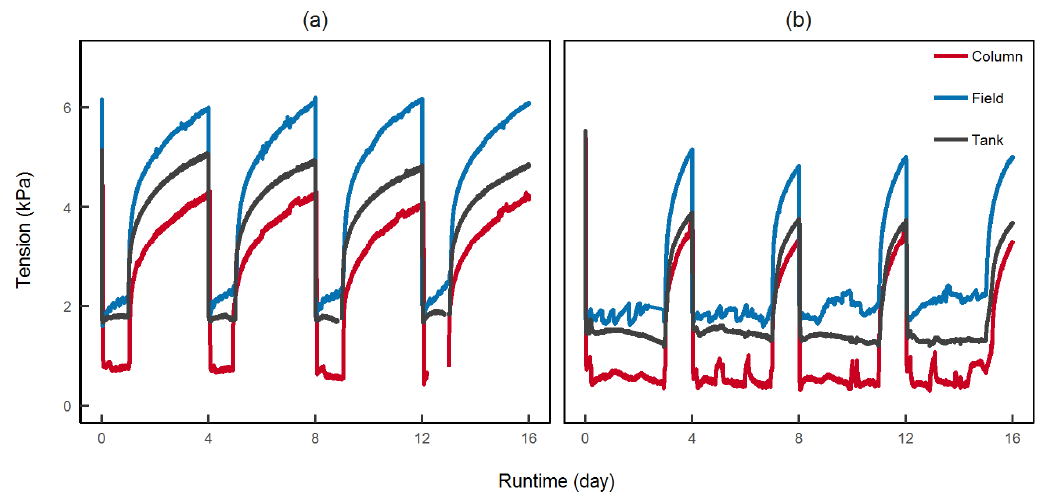
Figure 6. Measured matric potential at point 2.2 in all experimental setups during ( a ) scenario 1 (wet/dry ratio: 24 h/72 h) and ( b ) scenario 4 (wet/dry: 72 h/24 h).